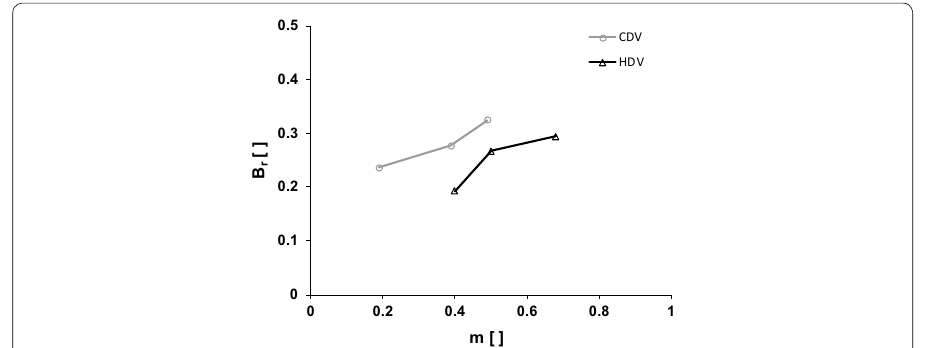
Fig. 16 Influence of particle breakage on the degree of convergence